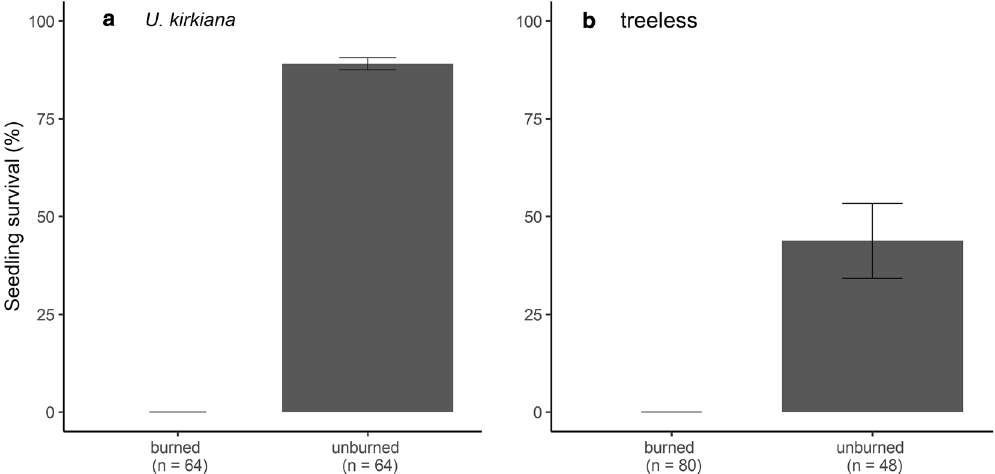
Figure 3. Comparisons of mean seedling survival (± 1 SE) between sites where fire occurred and those where it did not.